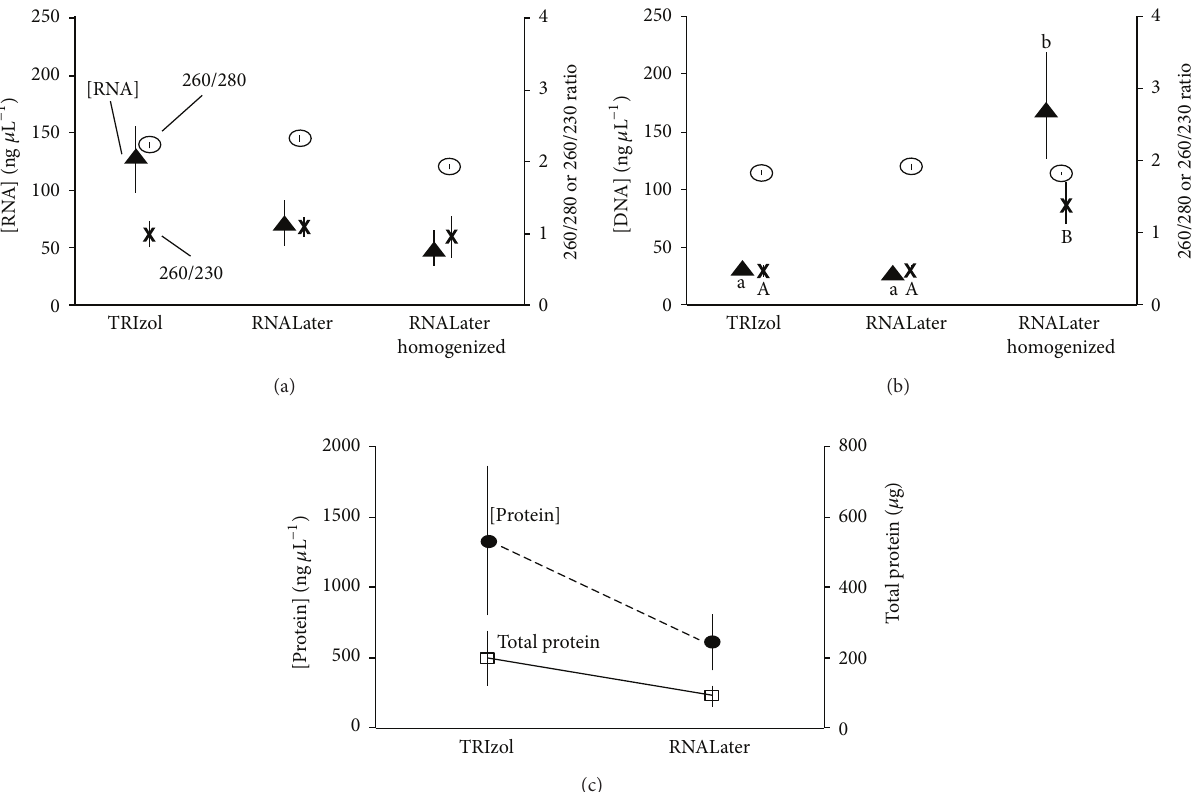
Figure 3: TRIzol versus RNALater. Six Seriatopora hystrix samples were collected from Houwan, and three biopsies ( ∼ 50mg) were removed from each and immersed in either TRIzol or RNALater as described in the text. Half of the samples stored in RNALater were homogenized and stored at − 20 ∘ C, while the other half of the samples were simply kept at 4 ∘ C. RNA, DNA, and, in certain cases, protein were extracted from the six biopsies of each fixation strategy treatment. RNA concentration ([RNA]; black triangles and left 𝑦 -axis) and 260/280 (hollow circles and right 𝑦 -axis) and 260/230 (exes and right 𝑦 -axis) ratios were compared between the three fixation strategies (a). Likewise, the DNA concentration ([DNA]; black triangles and left 𝑦 -axis) and 260/280 (hollow circles and right 𝑦 -axis) and 260/230 (exes and right 𝑦 - axis) ratios were also compared (b). In panel b, the lower case letters adjacent to icons represent Tukey’s honestly significant difference (HSD) groups ( 𝑃 < 0.05 ) for the [DNA] data, while upper case letters represent HSD groups for the 260/230 ratio data. Both protein concentration ([protein]; black circles connected by a dotted line and left 𝑦 -axis) and total protein (hollow squares connected by a solid line and right 𝑦 -axis) were compared between only two fixation strategies, immersion in either TRIzol or RNALater (without homogenization) (c). In all panels, error bars represent standard error of the